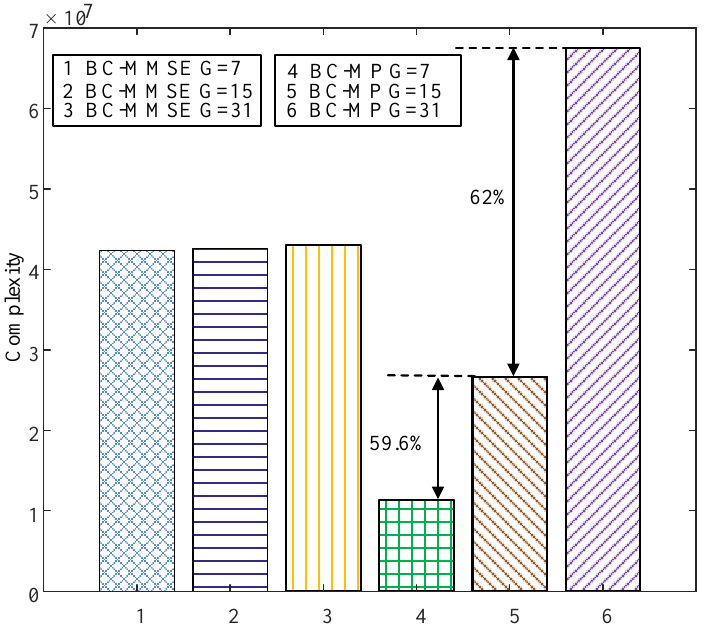
Figure 9. Complexity comparisons of the proposed BC-MMSE and BC-MP detectors for the GSTFIM systems with different numbers of effective subcarriers G in three iterations.